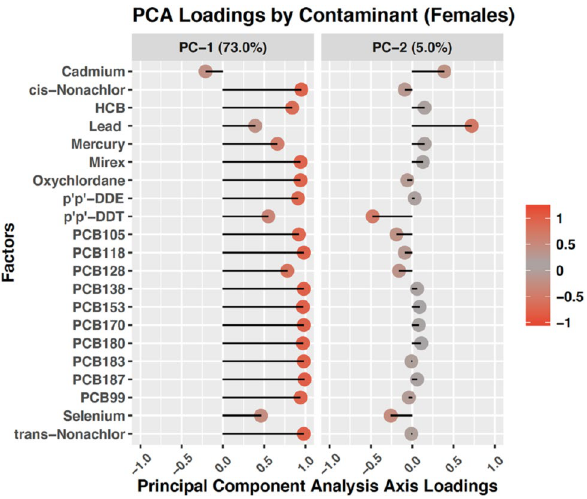
Figure 2. Principal component (PC) loadings of contaminants. Part of this Figure is reproduced from Zuk et al. 33 .